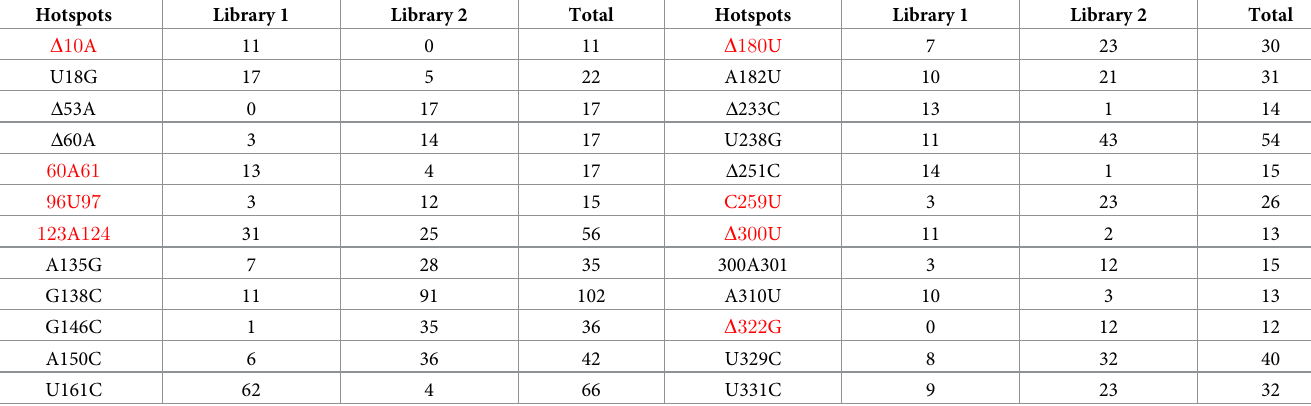
Table 3. Mutation hotspots identified by deep sequencing progeny